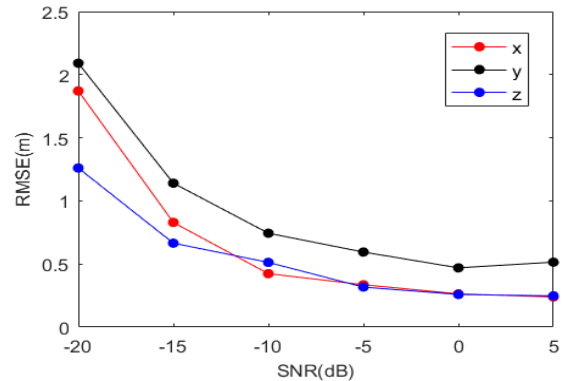
Figure 12. RMSE under different SNR.